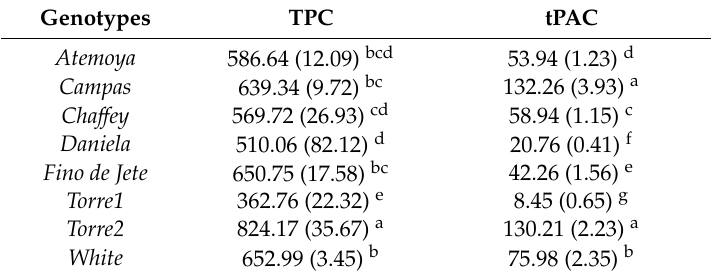
Table 1. Total polyphenol content (TPC) and total proanthocyanidin content (tPAC) of the seven extracts of Cherimoya and Atemoya leaves. TPC was measured by Folin-Ciocalteu method and its related values are expressed as mg of gallic acid equivalent (GA equivalent) per 100 g of dried material (d.wt). tPAC was measured by DMAC assay and its related values are expressed as mg of PAC-A equivalent per 100 g of d.wt. Values are expressed as mean (SD) of three experiments carried out in